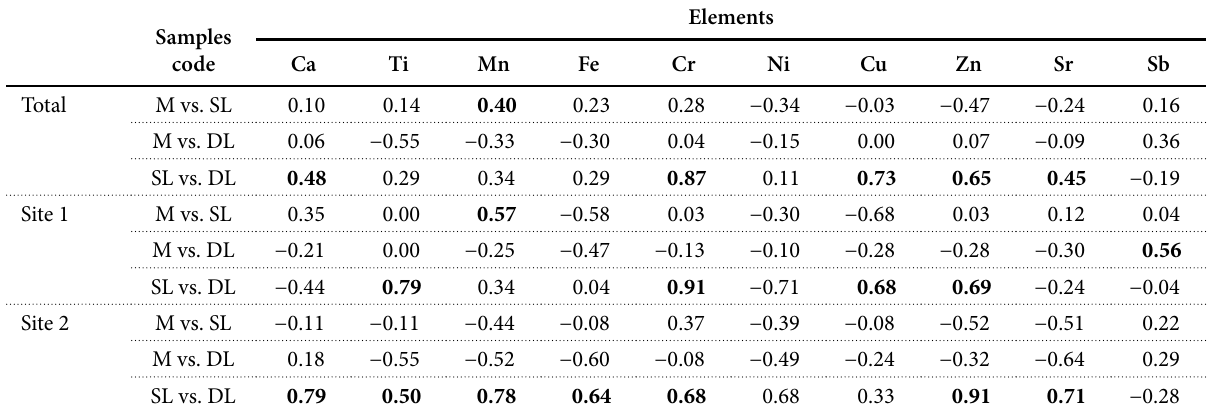
Tab. 6 Pearson correlation values ( r ) among the mushroom samples (M) versus the soil layers (surface soil – SL and deep soil – DL).